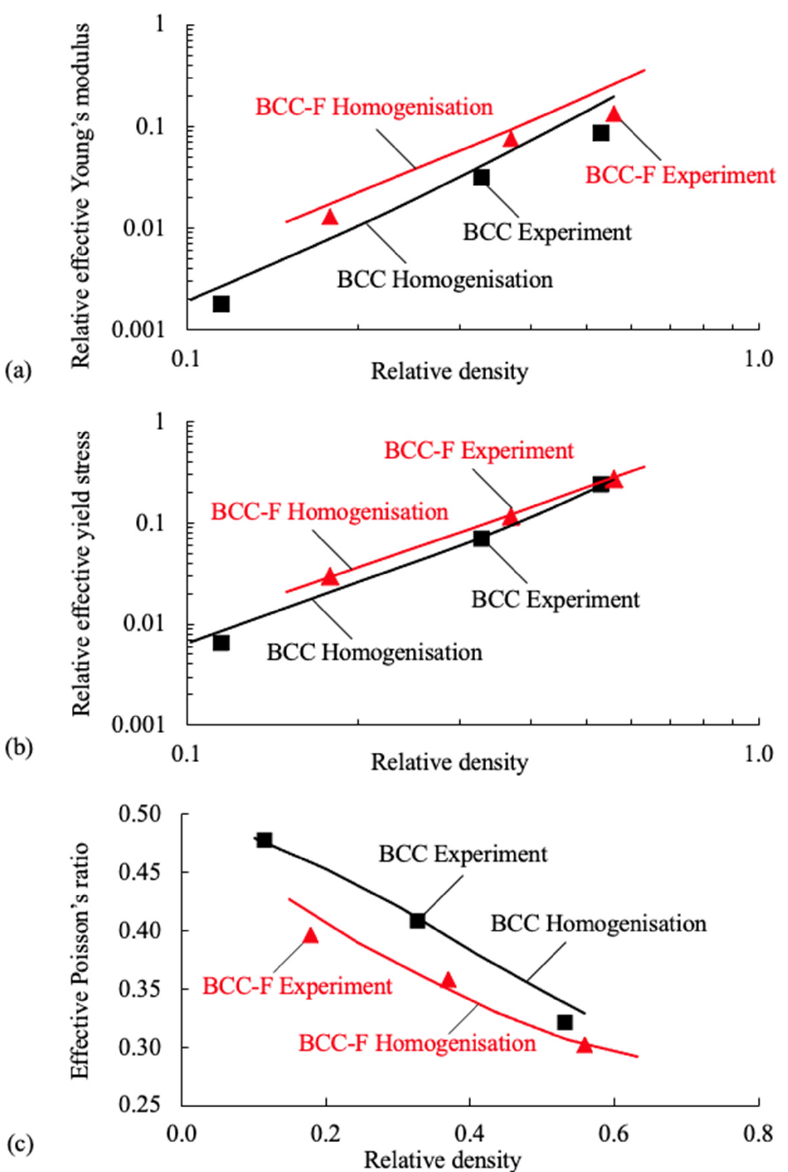
Figure 10. Experimental (symbols) and numerical homogenisation (solid lines) results of ( a ) the relative effective Young’s moduli (log-log scale), ( b ) the relative effective yield stresses (log–log scale), and ( c ) the effective Poisson’s ratios (linear scale) of the BCC and the BCC-F lattices at different relative density levels.